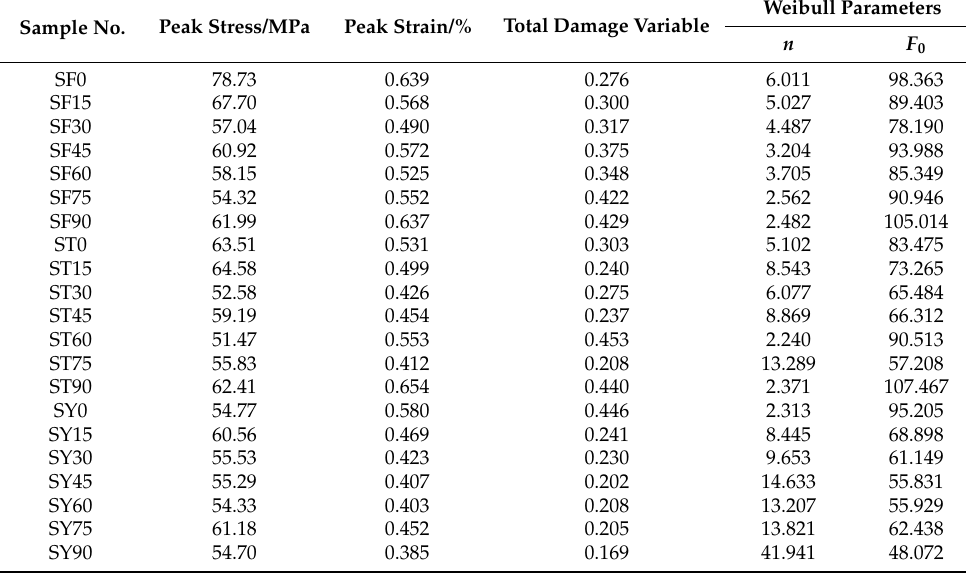
Table 5. Physical and mechanical properties of the samples with prefabricated fractures. Sample